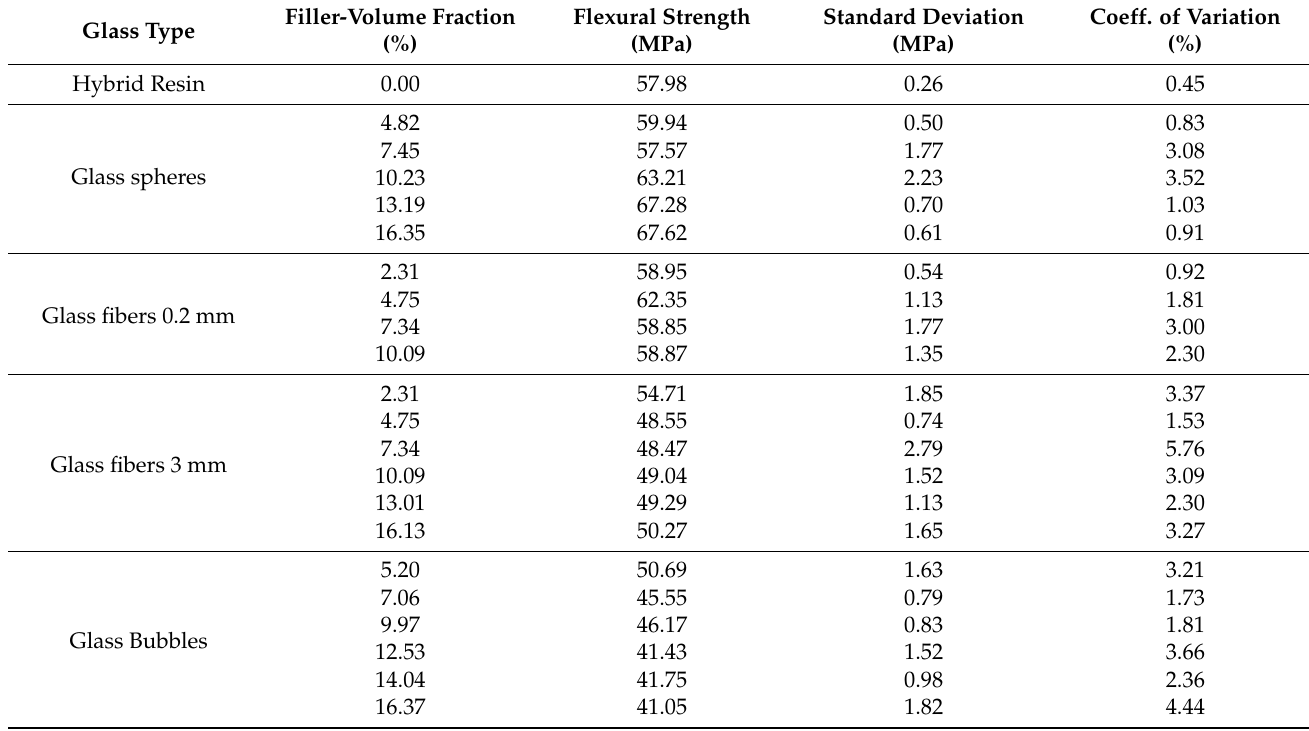
Table 4. Statistical analysis of the flexural strength